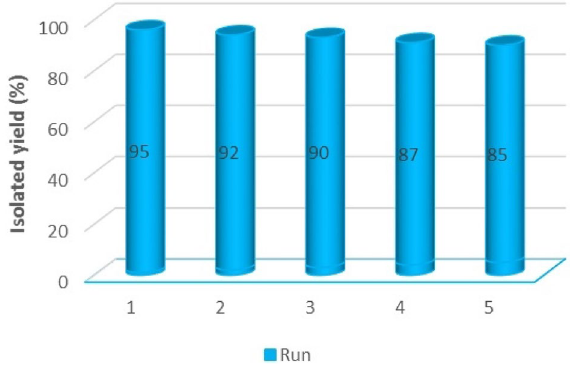
Figure 10. Investigation of the feasibility for reusing of Iron oxide@PMO-ICS-PrSO 3 H magnetic mesoporous catalyst ( 1 ) in the synthesis of 12-(4-chlorophenyl)-3,3-dimethyl-1,2,3,4,5,12-hexahydrobenzo[4,5] imidazo[2,1- b ]quinazolin-1-one ( 6a ).